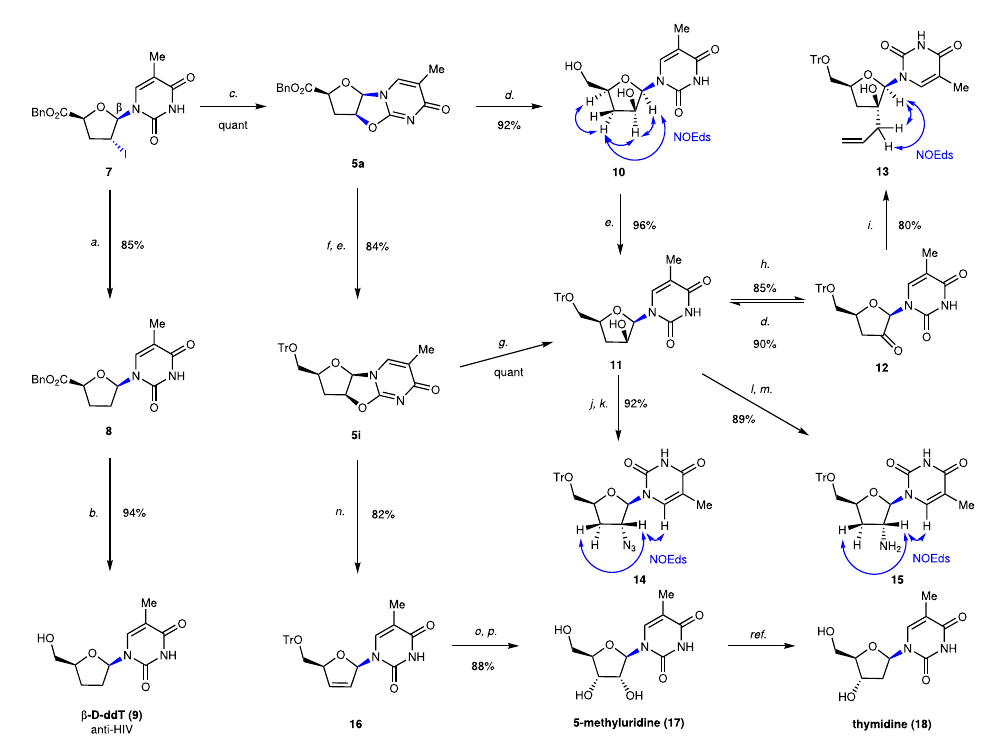
Fig. 5 | Derivatizations of β -nucleoside 7 . Conditions: a . Bu 3 SnH, AIBN, PhMe, re fl ux,85%; b .NaBH 4 ,THF:H 2 O=3:1,0°Ctort.,94%; c .DBU,PhMe:CHCl 3 =1:1,0°C, quant; d . NaBH 4 , THF:H 2 O=3:1, rt., 92% of 10 , 90% yield of 11 ( 12 to 11 ); e . TrCl, pyridine, DMAP, CH 2 Cl 2 , re fl ux; f . NaBH 4 , THF:H 2 O=3:1, 0°C, 84% yield over two step ( 5a to 5i ); g . NaOH aq. (2.0M), CH 3 CN, rt., quant; h . NMO, TPAP, CH 2 Cl 2 , rt.,